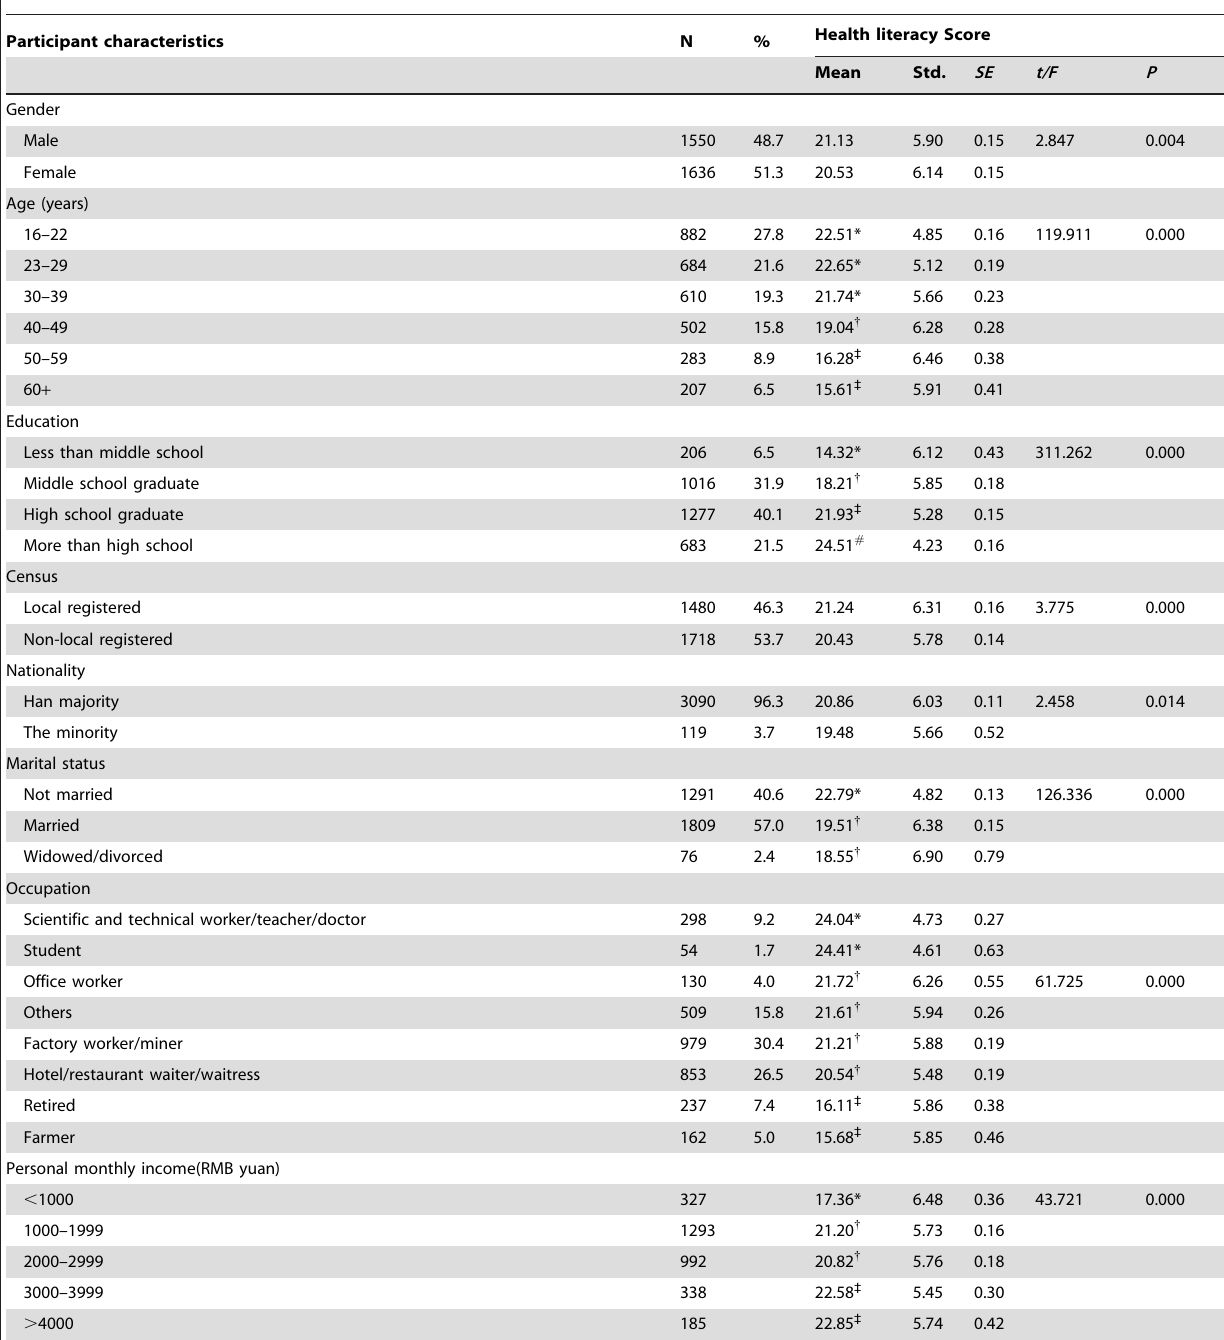
Table 1. Comparison of health literacy scores by participant